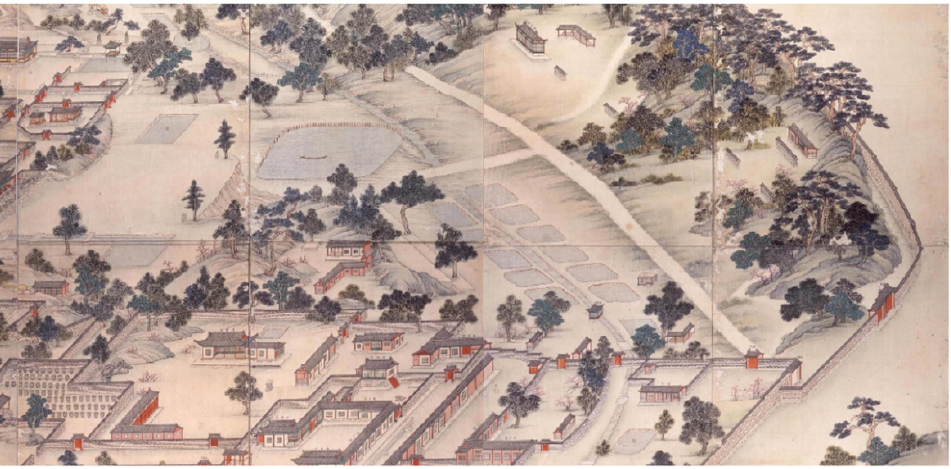
Figure 1. Paddy fields inside the palace displayed in the Donggwoldo painting, 1828–1830. Ink and colors on silk, 584 cm × 273 cm. Korea University Museum, Seoul.